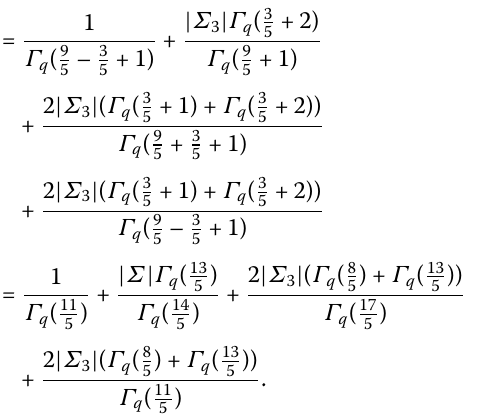
Table 1 Some numerical results for Σ 1 , Σ 2 , and Σ 3 in Example 1 for q = 1